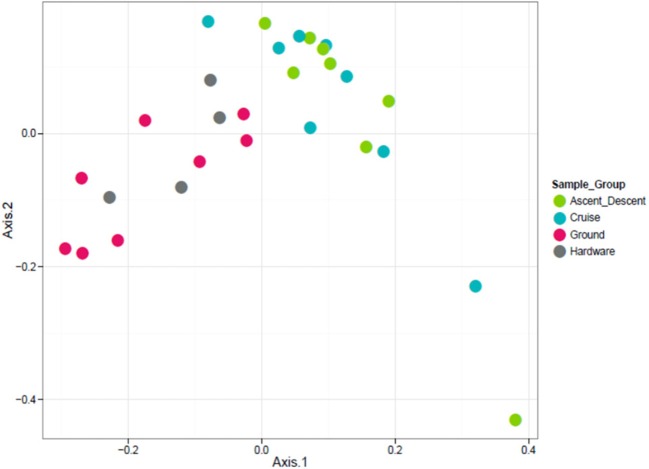
Unweighted ordination based on presence/absence showed non-significant clustering in sample groups. Flight samples (Cruise and Ascent/Descent) separated from the Ground and Hardware samples. The first two ordination axes accounted for 23.2% of sample variation.